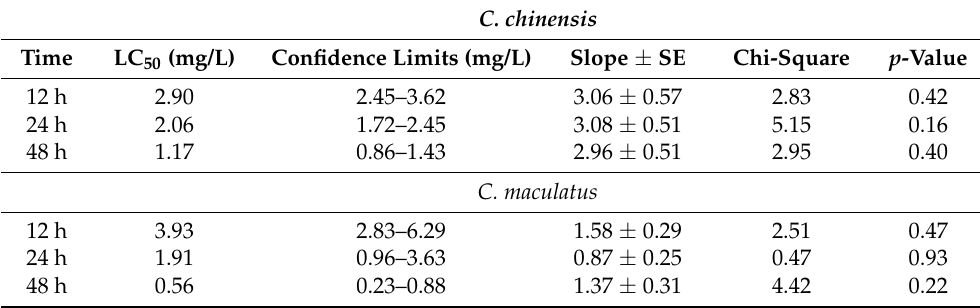
Table 2. Fumigant toxicity of A. maritima oil against C. chinensis and C. maculatus .